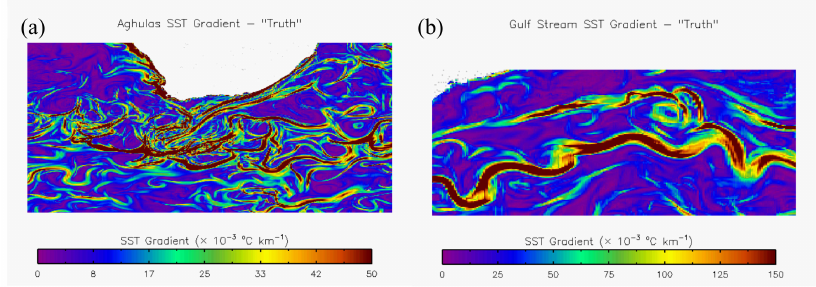
Figure 12. Gradient of the SST field in January in the “truth” data set for: ( a ) Aghulas Current region and ( b ) Gulf Stream region.